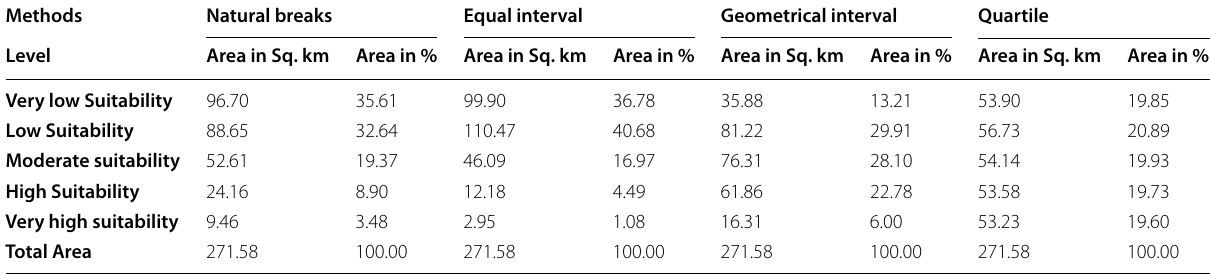
Source: Computed by the author